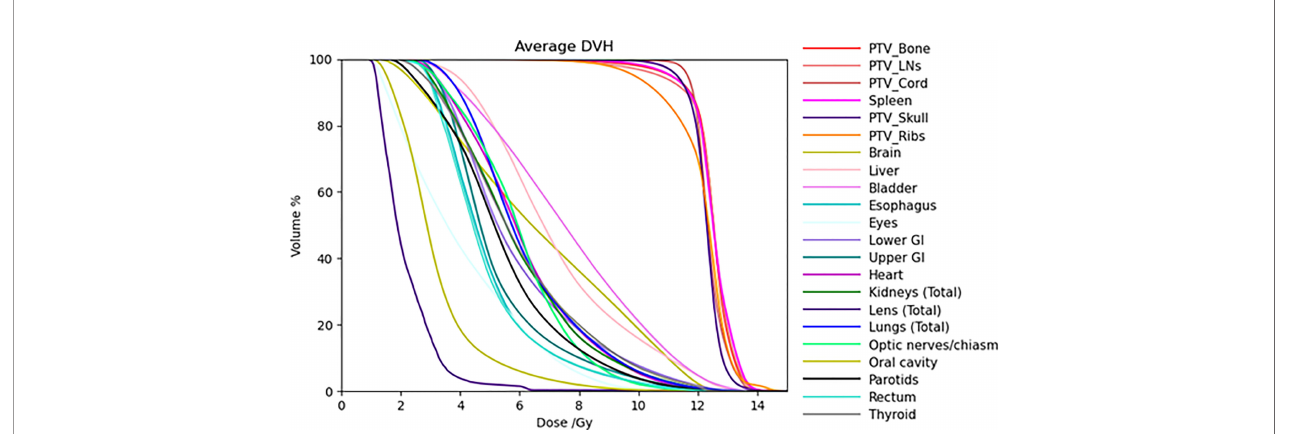
FIGURE 1 | Average DVHs of all the treatment plans for target volumes and most normal organs in the